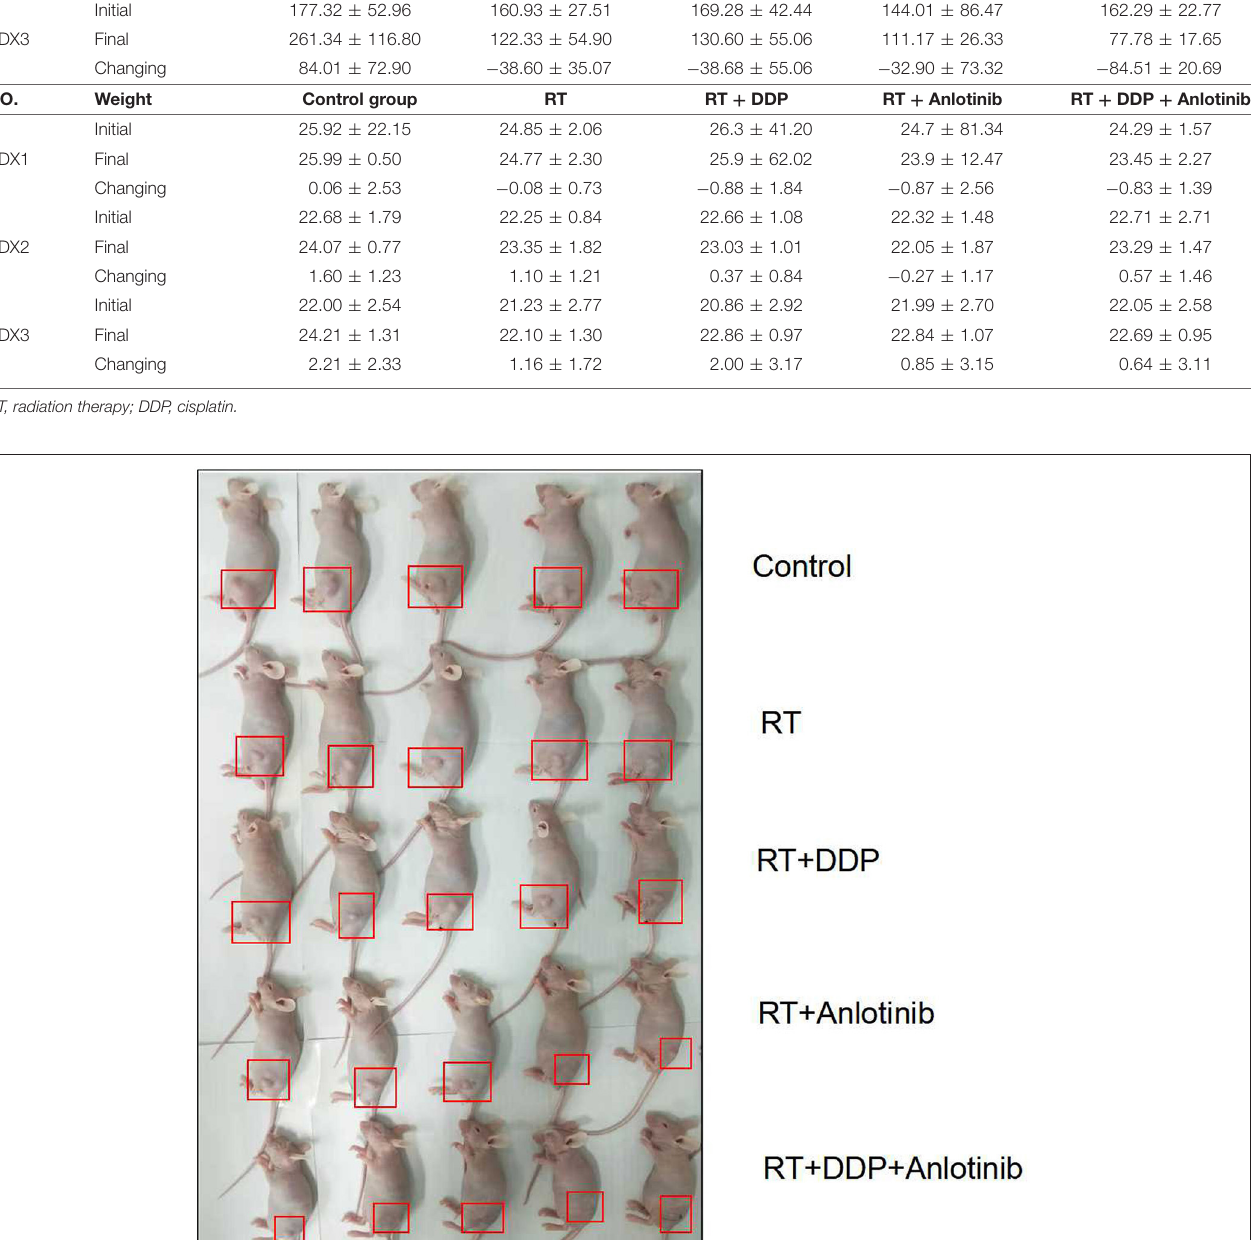
Frontiers in Oncology |